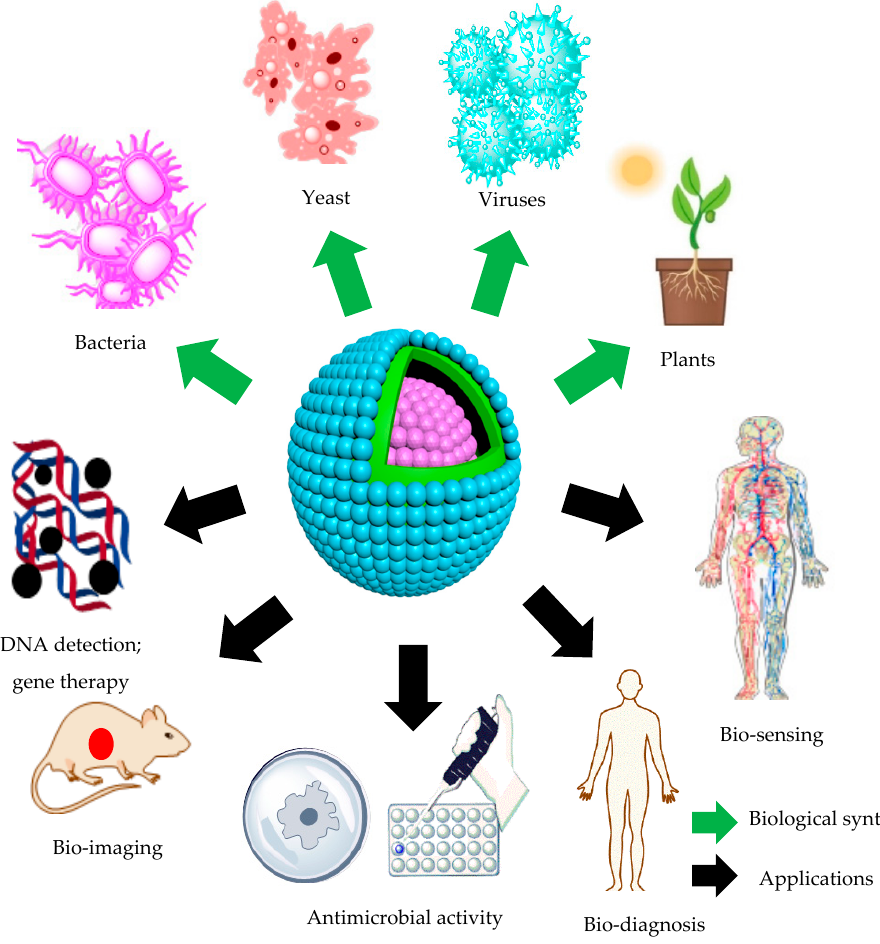
Figure 4. Scheme representing the di ff erent biological entities used for the biological fabrication of quantum dots (QDs) and their various applications.